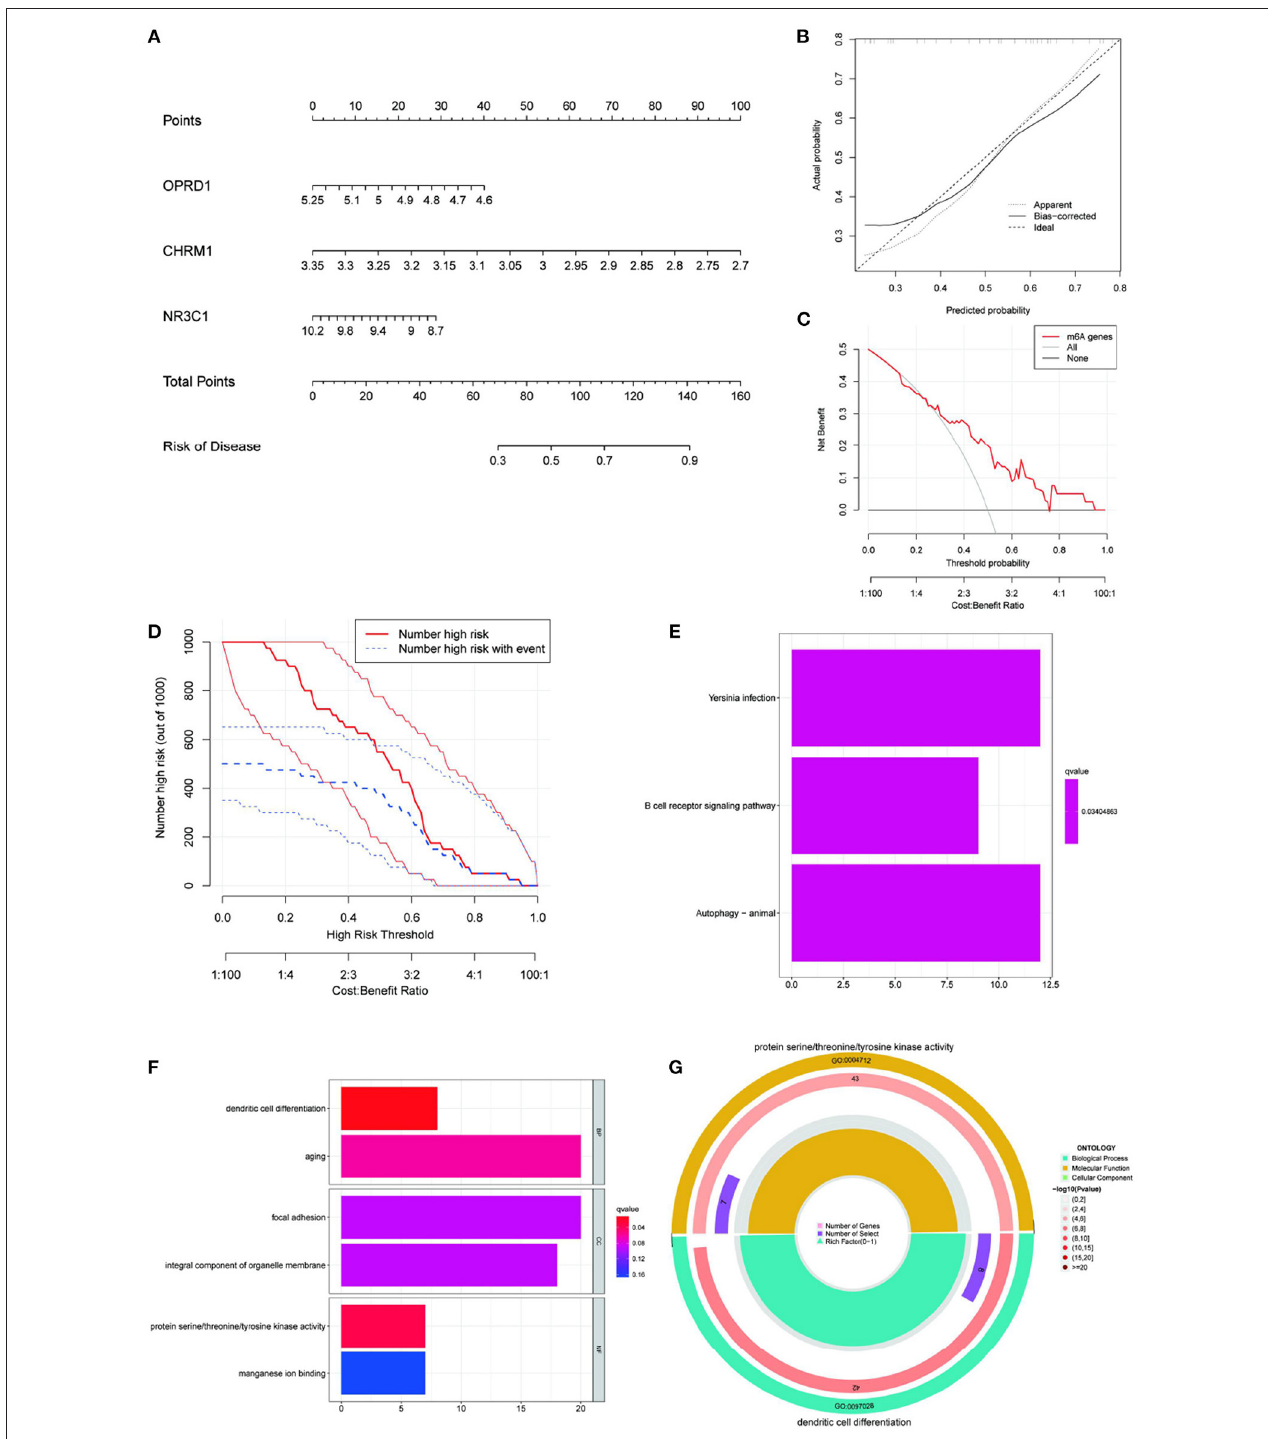
FIGURE 7 | Construction of nomogram prediction model and enrichment analysis based on this model. Construction an IS nomogram model based on the selected genes CHRM1, NR3C1, ADRB2, and OPRD1 (A) ; Calibration curve showing the diagnostic power of the nomogram model (B) ; DCA shows that the nomogram model has a good clinical application (C) ; Clinical impact curves show high diagnostic power of the nomogram model (D) ; KEGG (E) and GO (F) enrichment analysis of the genes included in this prediction model (E,F) ; The most significant GO enrichment pathway associated with this predictive model (G) .